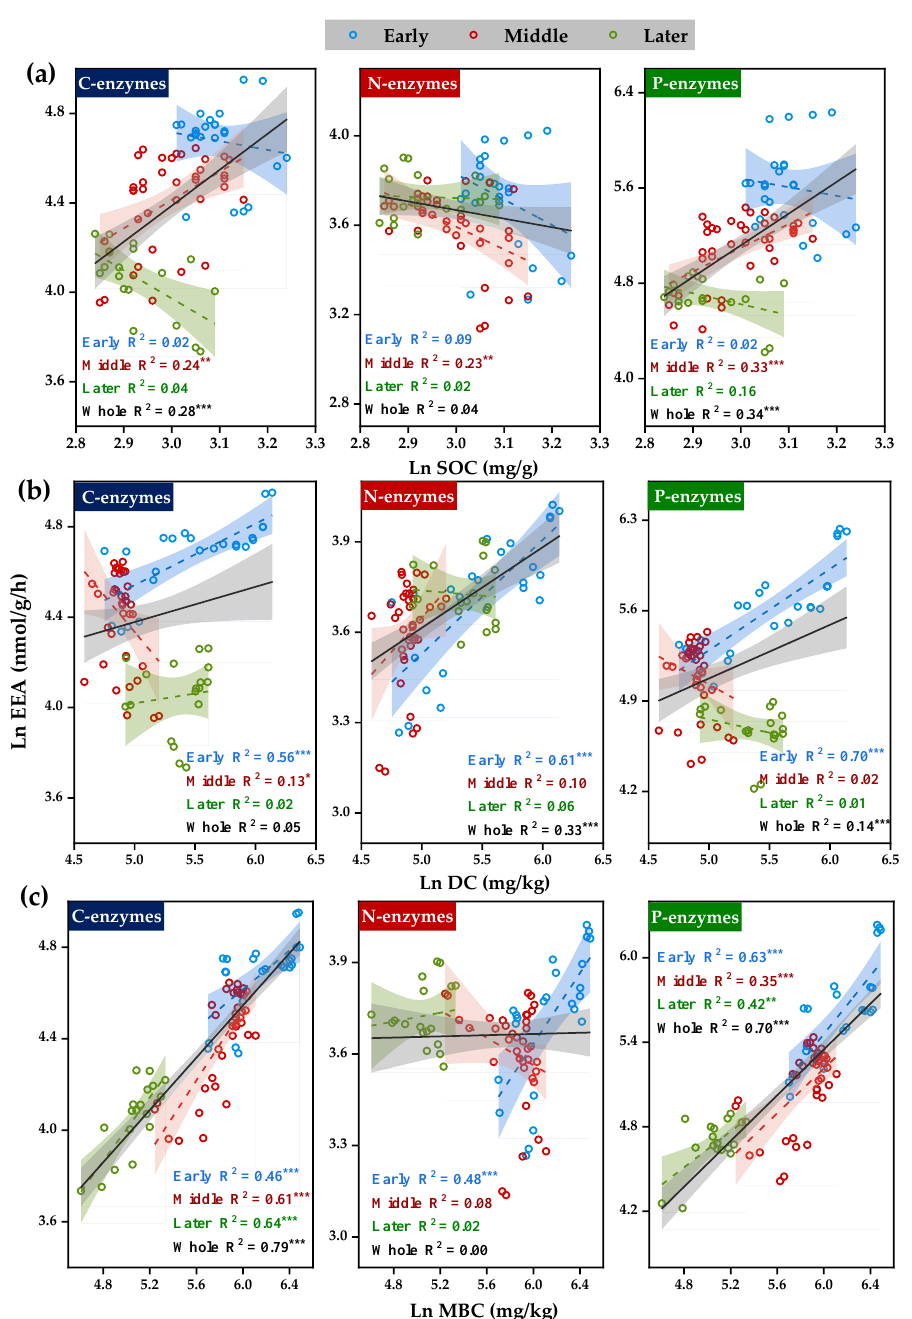
Figure 3. Relationship between soil extracellular enzyme activities (EEAs) and soil C fractions. ( a ) C-enzymes (BG+CBH) and soil organic C (SOC); N-enzymes (LAP+NAG) and SOC; P-enzymes (AP) and SOC. ( b ) C-enzymes and dissolved C (DC); N-enzymes and DC; P-enzymes and DC. ( c ) C- enzymes and microbial biomass C (MBC); N-enzymes and MBC; P-enzymes and MBC. * p < 0.05, ** p < 0.01, and *** p < 0.001.